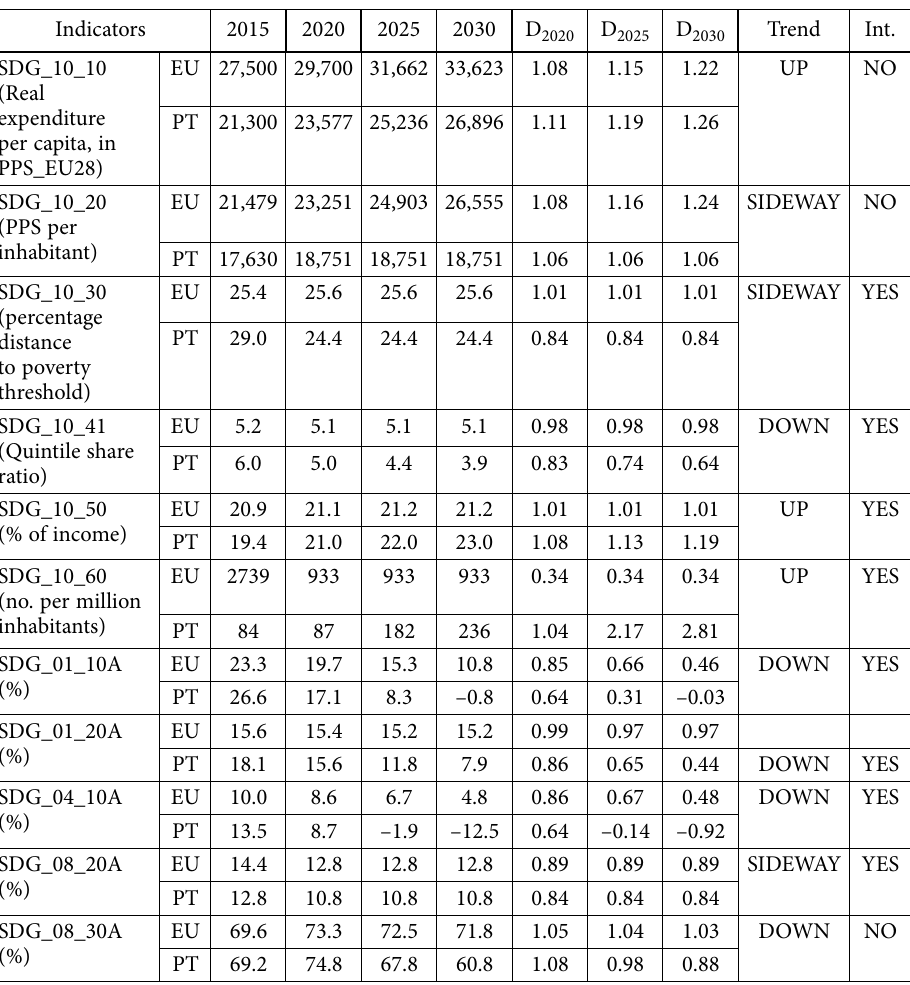
Table 11. SDG 10 – Reduced inequalities